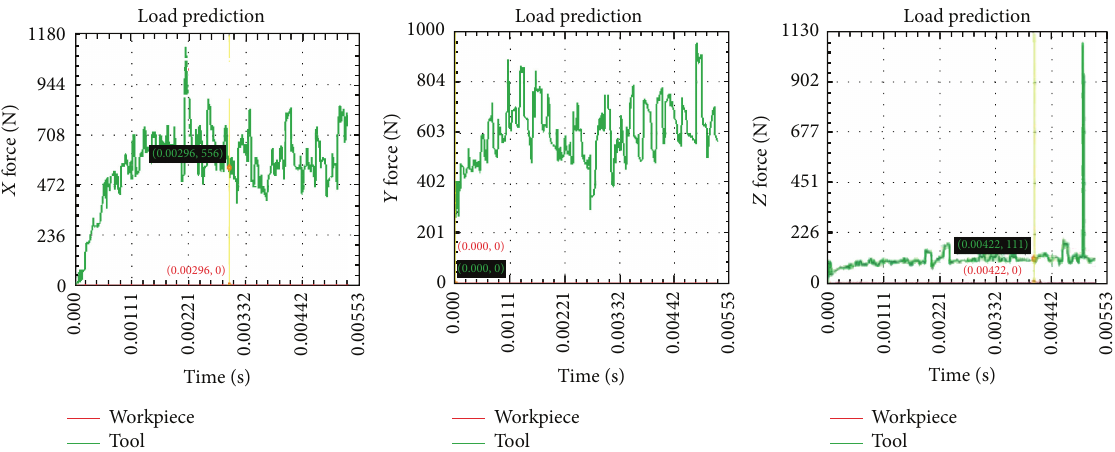
Figure 3: Simulation results of milling forces in 𝑥 , 𝑦 , and 𝑧 directions.